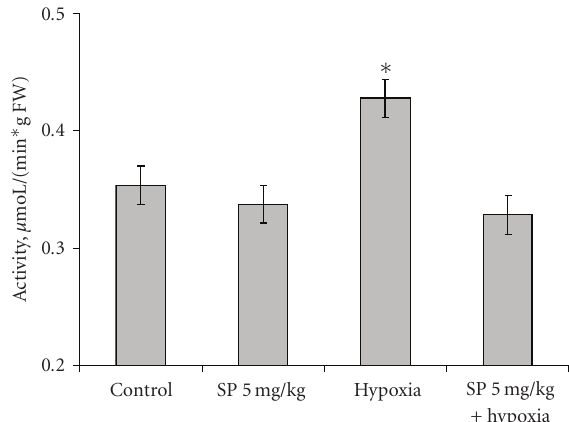
Figure 7: Influence of 5mg/kg SP on the elevation in the cortex activity of OGDHC, induced by acute hypoxia in pregnant rats. Statistical significance: ∗ P < . 05